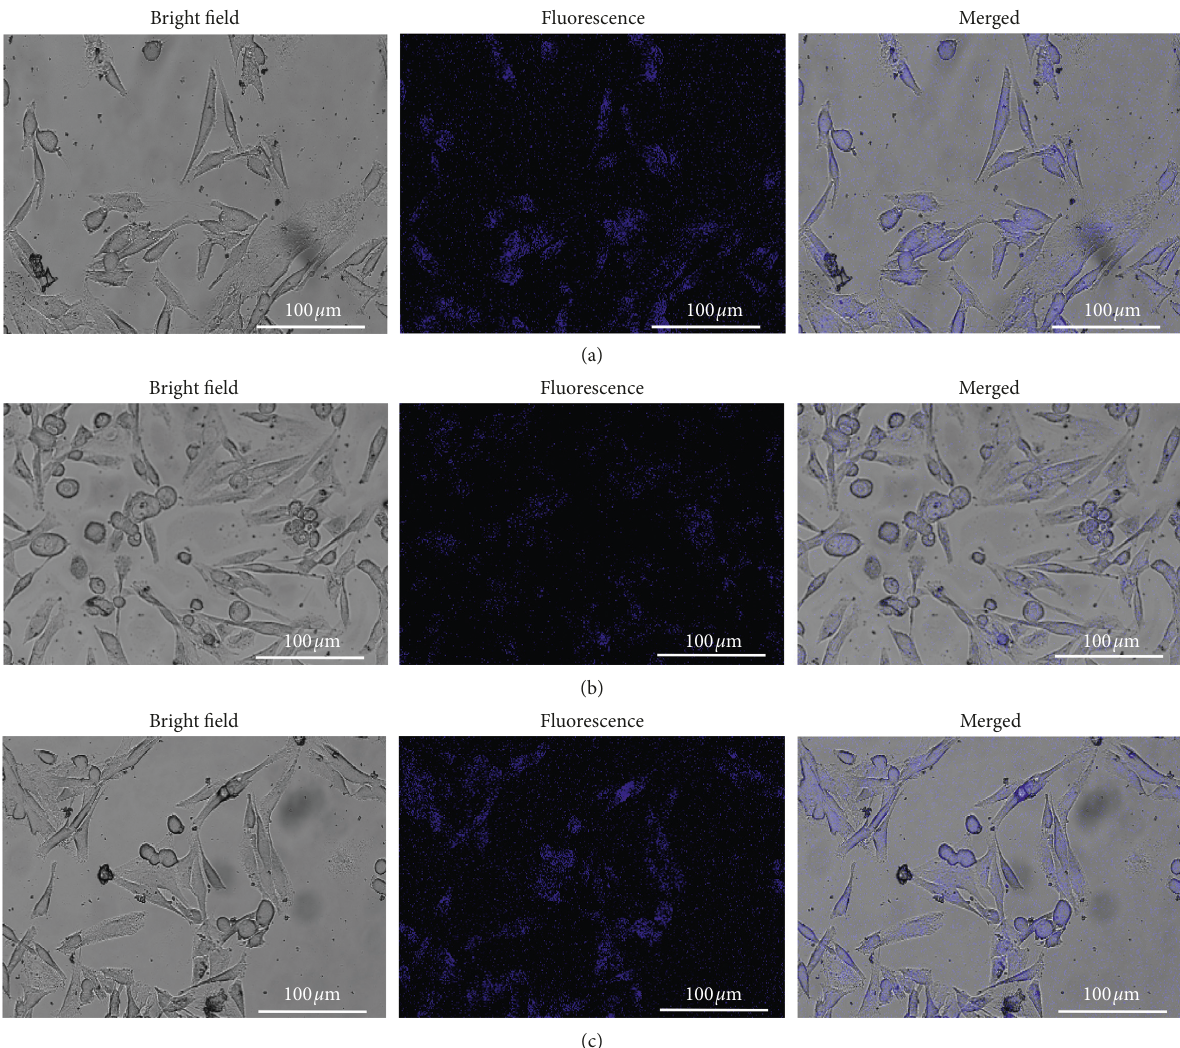
Figure 9: Confocal fluorescence images of SK-hep1 cells. The images from (a) to (c) were cells incubated with probe NRPCNSs (40 μ g/mL) for 8 h at 37 ° C, then incubated with Ag + (100 μ M) for 30min at 37 ° C, and then incubated with Cys (100 μ M) for 30min at 37 ° C, respectively. Fluorescence images were taken at 405nm